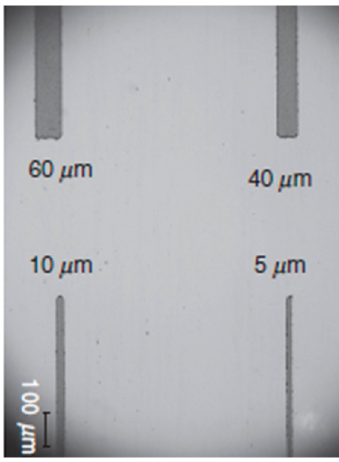
Figure 21. Micro-patterning of piezoelectric layers deposited via AD using the lift-off process with photoresist [2]. © Copyright 2008, J. Therm. Spray Technol.